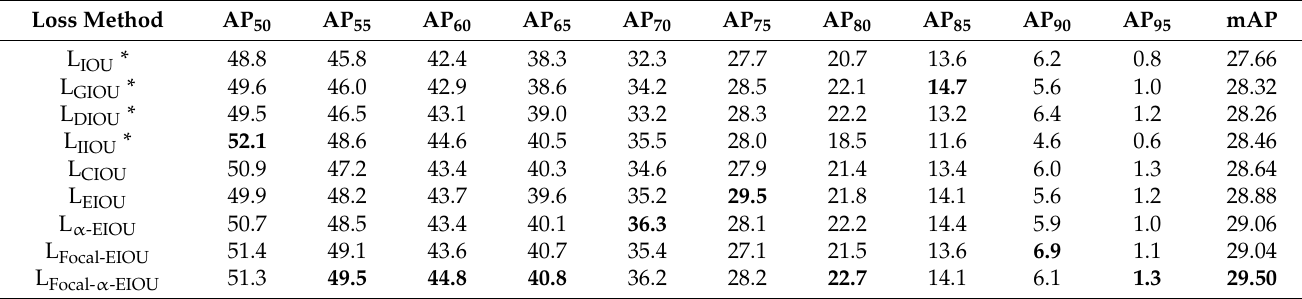
Table 5. CGMU test detection